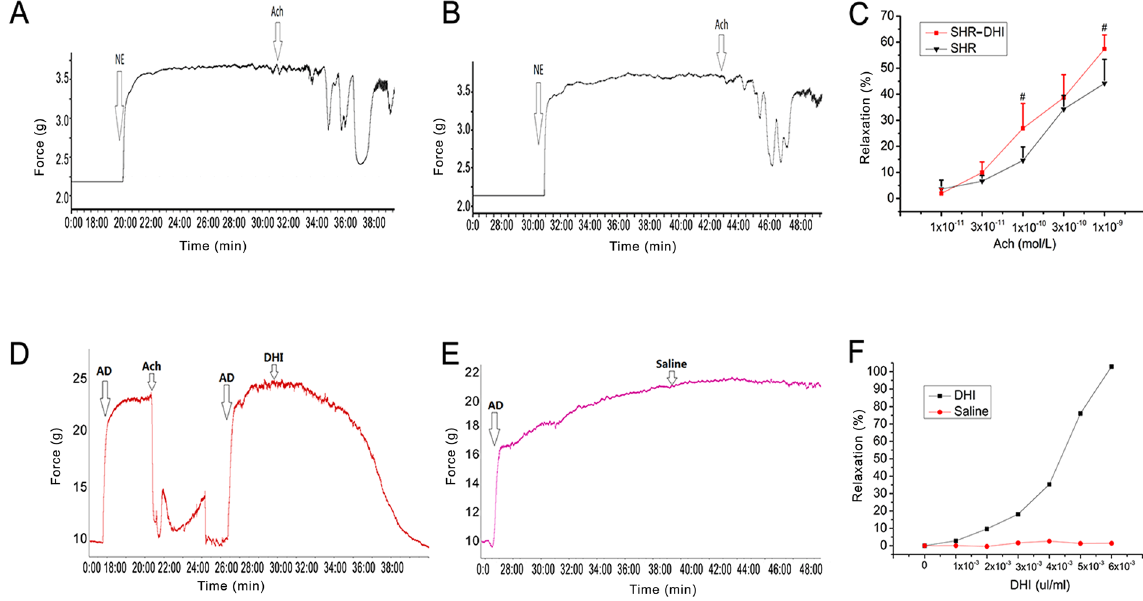
Figure 4. In vivo and ex vivo effects of DHI on mesenteric arteries from SHR and wild-type rats. ( A , B ) Raw traces of relaxation of NE-precontracted MAs from SHR in response to ACh (DHI vs. Saline treatment). ( C ) Quantitation of data in A and B expressed as % relaxation in response to increased Ach concentrations. ( D , E ) Raw traces of relaxation in response to ACh (DHI vs. Saline treatment) on AD pre-contracted mesenteric arteries. ( F ) Quantitation of data in ( D and E ) expressed as % relaxation in response to increased DHI concentrations. The rate of Ach or DHI-induced relaxation was calculated with NE (10 mM) or AD (10 mM) contraction set as 100%. ( A and B ) Mesenteric arteries from DHI-treated SHR animals for three days significantly relaxed more than that of saline control in response to increasing doses of ACh, p < 0.01. ( D and E ) DHI treatment also caused a direct endothelial-dependent vasorelaxation in AD pre-contracted mesenteric arteries from normal (WKY) rats, p < 0.01. All data are expressed as mean ± SEM, n =